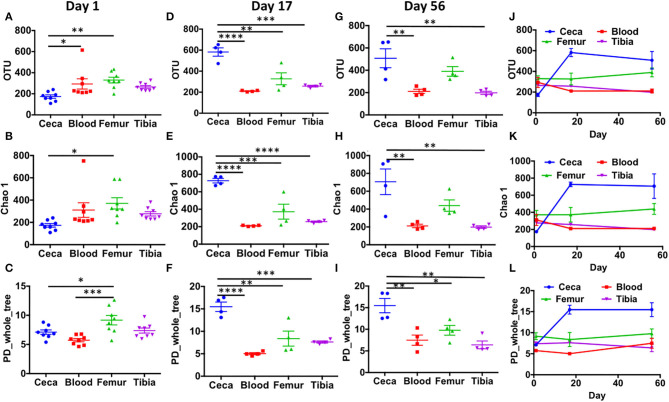
Alpha diversity in ceca, blood, femur, and tibia of chickens. CSS normalized OTU table was used to calculate alpha diversity indices like number of observed OTUs (OTU), chao1, and phylogenetic distance whole tree (PD_whole_tree). Bacterial diversity in day 1 (A–C), day 17 (D–F), and day 56 (G–I) across the different sites (ceca, blood, femur, and tibia). (J–L) The trend in bacterial diversity within different sites across the ages (days 1, 17, and 56) of chickens. Data are mean ± standard error (S.E.). Samples were analyzed by ANOVA and Tukey's multiple-comparison test. *p < 0.05, **p < 0.01, ***p < 0.001, ****p < 0.0001.